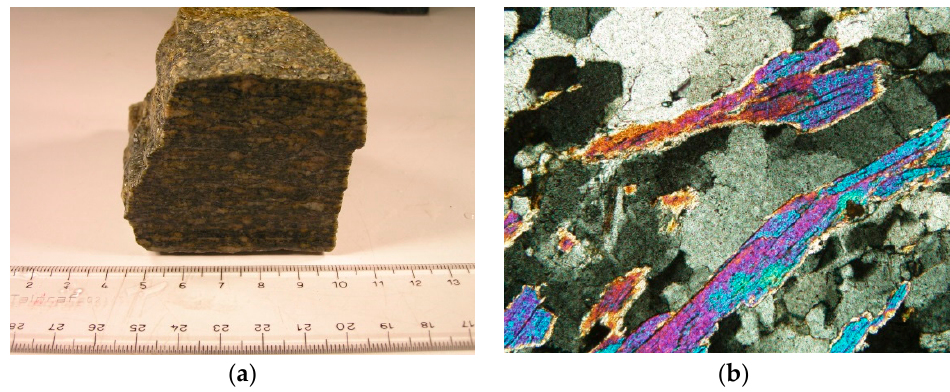
Figure 1. ( a ): macroscopic photo of Luserna stone; ( b ): microscopic photo of Luserna stone with its characteristic schistose texture due to white mica minerals orientation, K-feld: Potassic feldspar, Fn: Fengite, Bt: Biotite. The microscopic photo was carried out with optical microscope Leika in crossed Nicols, magnification 20×.